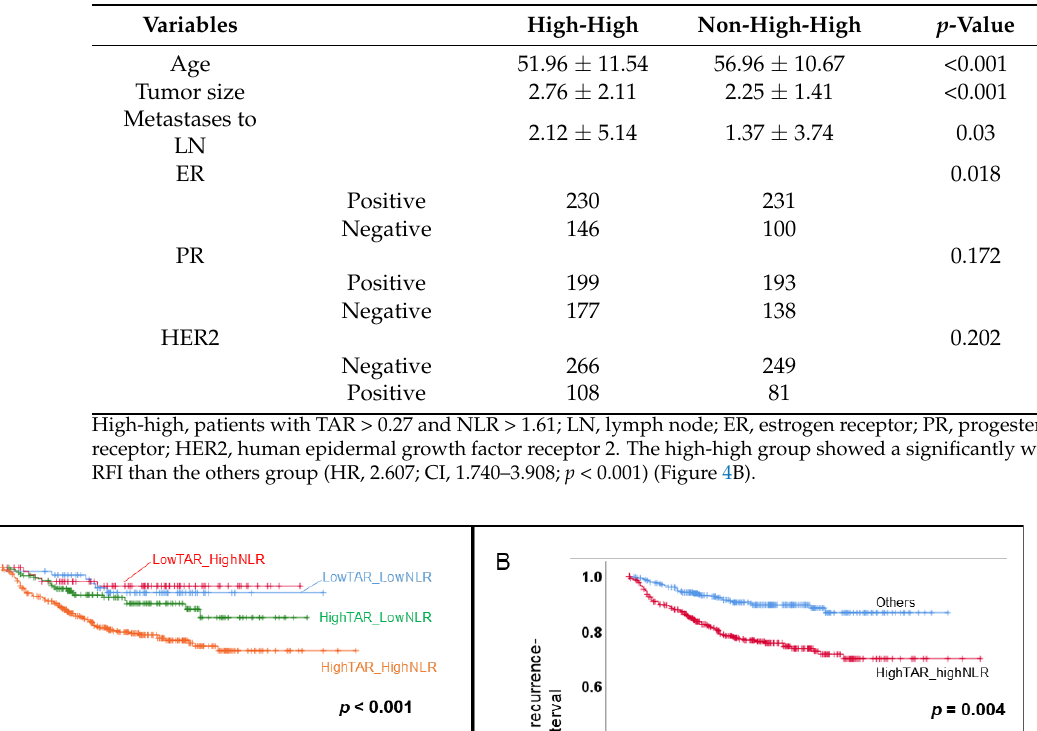
Table 3. Clinicopathologic characteristics of two groups, high-high and the others.